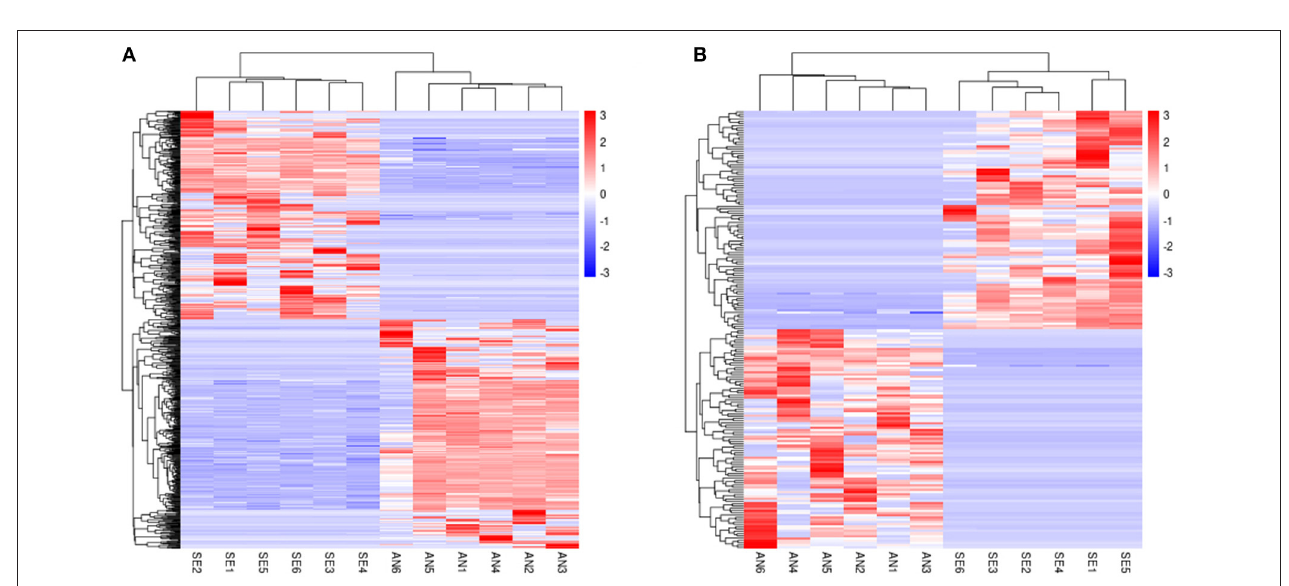
FIGURE 2 | Volcano plot of differentially expressed (DE) mRNAs (A) and lncRNAs (B) in antagonism group (AN) vs. sensitive group (SE), where red and green represent up or downregulation, respectively.